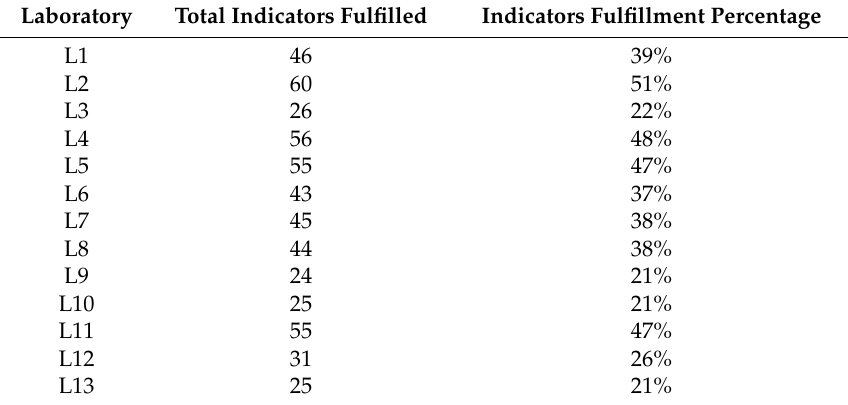
Table 4. Potential laboratories readiness level.